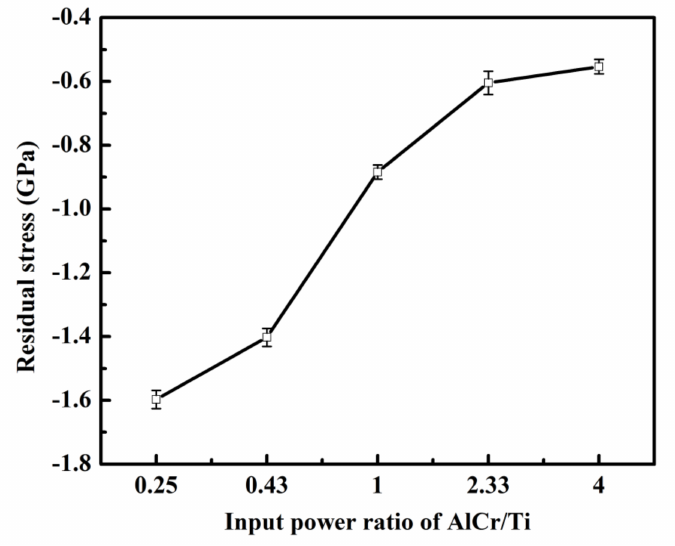
Figure 9. Residual stress of the AlTiCrN coatings deposited under various AlCr:Ti input power